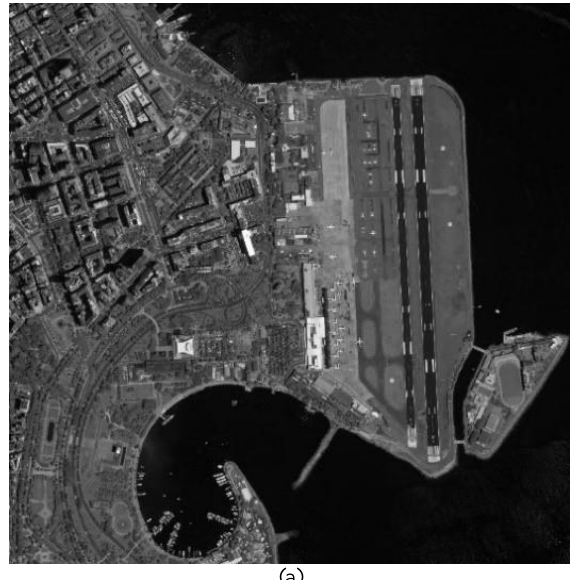
Figure 4. a) Disparity map without consistency check, b) disparity map with consistency